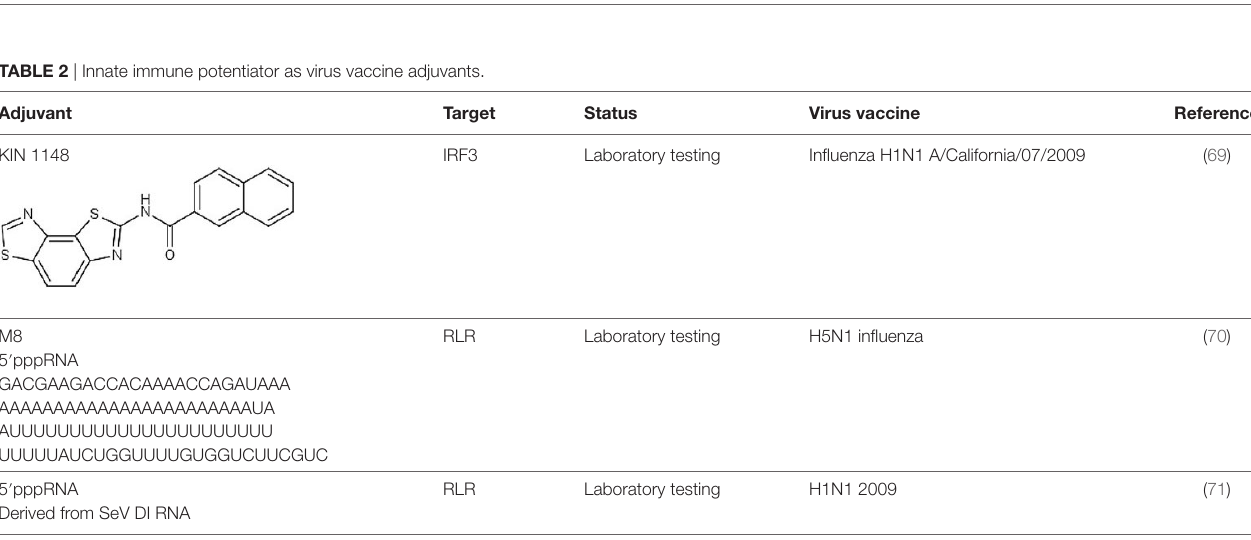
FiGURe 2 | The use of innate immune potentiator as adjuvant triggers the stimulation of adaptive immune responses. Innate immune potentiator stimulates RIG-I-like receptors (RIG-I) and interacts with MAVS adapter. This results in the activation of downstream signaling pathways and release of type I interferon. Type I interferon couple with the presence of antigen trigger DC maturation by enhancing surface marker expression and antigen presentation. The activated DCs interact with CD4 + T cells and thus stimulate Type 1T helper (TH1) cells. TH1 cells in turn interact with B cells to produce antibodies and trigger clonal expansion of B cells and T helper